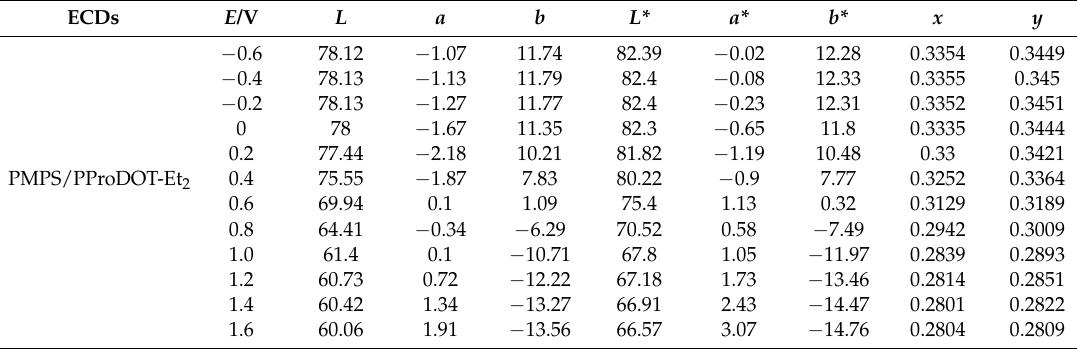
PMPS/PProDOT-Et